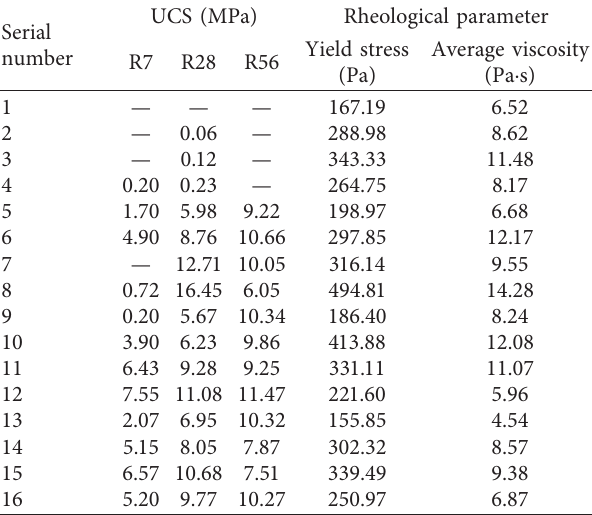
Table 3: Test results of mechanical properties.